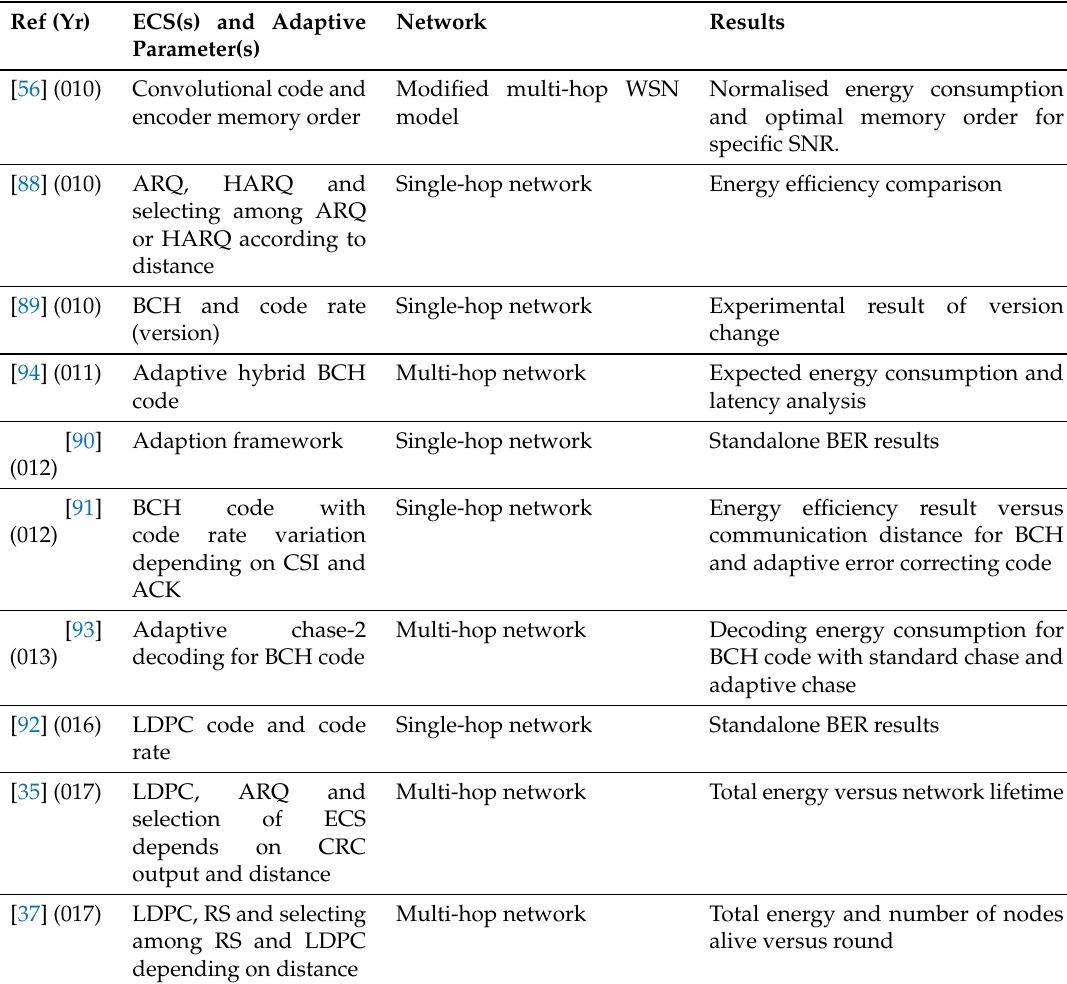
Table 4. A summary of adaptive ECS for